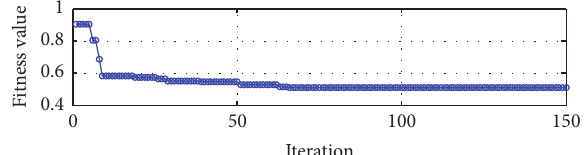
Figure 7: PSO results for minimum 𝐽